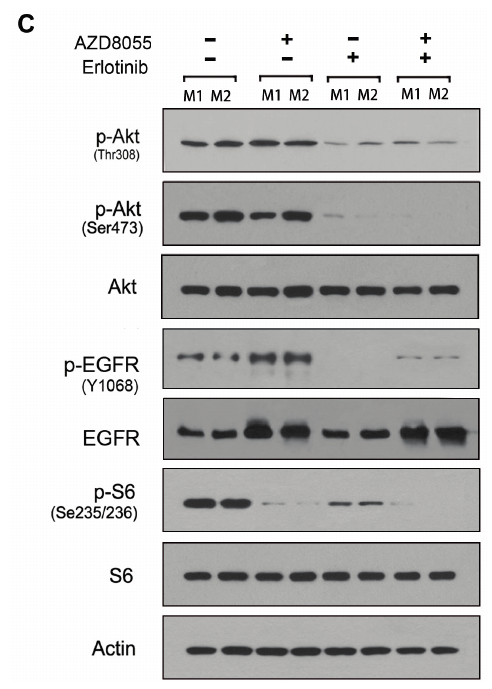
Figure 5. EGFR inhibition improves antitumor efficacy when given in combination with AZD8055. ( A ) The tumor volumes from the same group mice were presented as mean ± SD. and statistically analyzed. *, p < 0.05 and **, p < 0.01 vs. AZD8055 treatment alone; ( B ) At necropsy, the representative xenografts were shown from the left to right with saline, AZD8055, erlotinib, AZD8055 and erlotinib combination; ( C ) the xenografts were lysed and subjected to western-blot for the presence of the indicated proteins in the xenograft